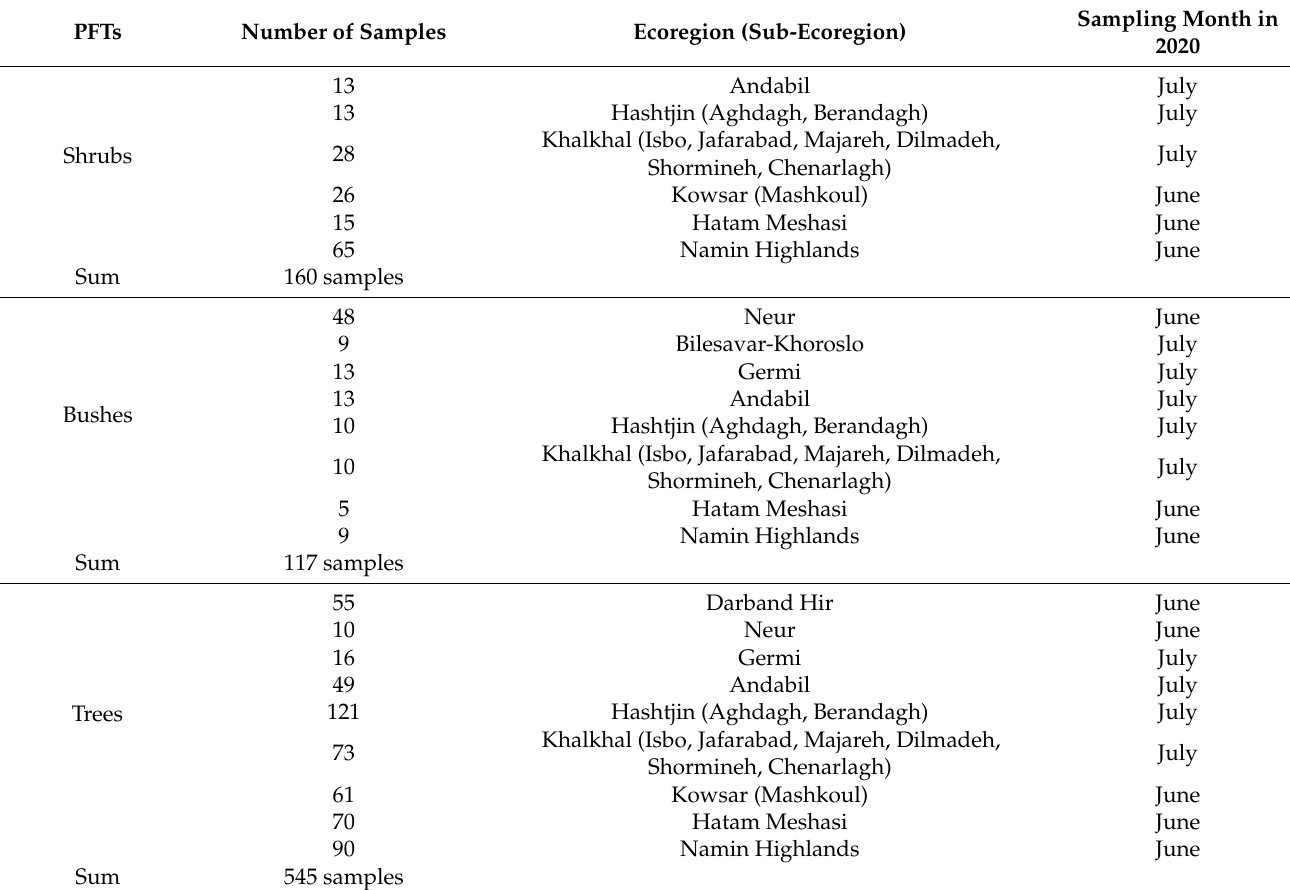
Table 1. Sampling number for each plant functional type (PFT) at the studied